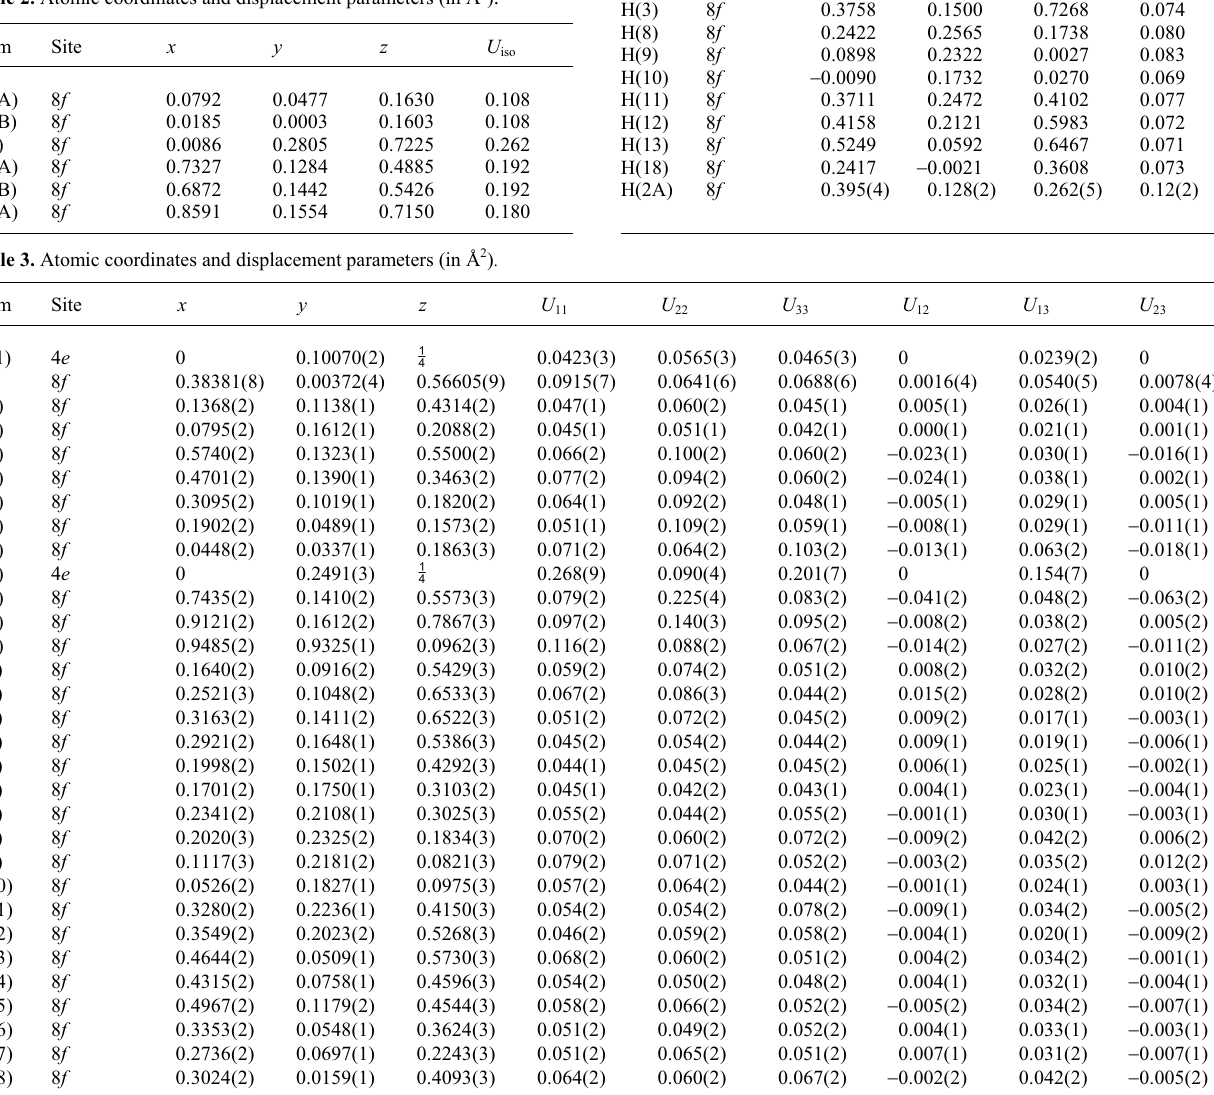
Table 2. Atomic coordinates and displacement parameters (in Å 2 ) .